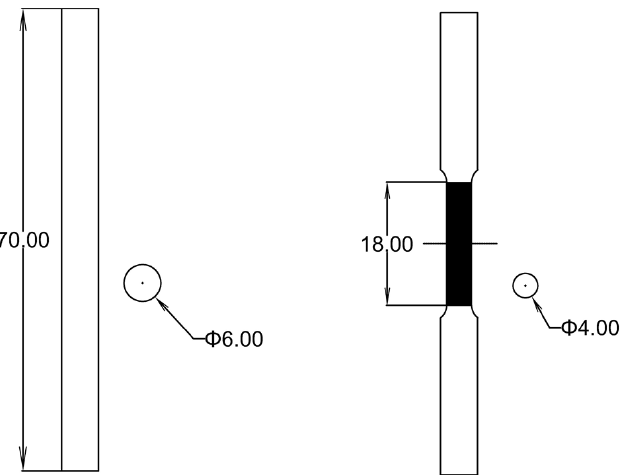
Figure 4. Specimen used for thermal simulation in the tensile test ( Φ = 4 and 6 mm in the picture).